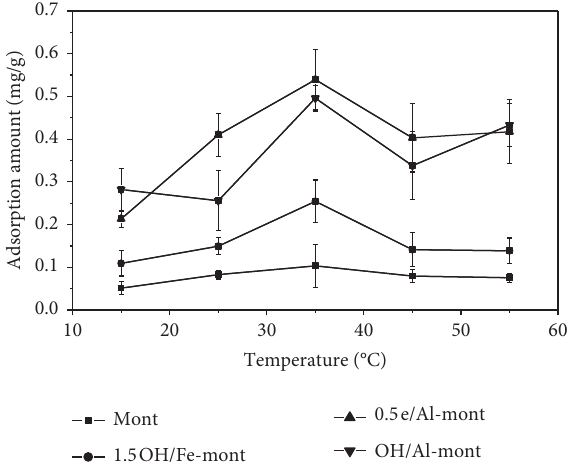
Figure 13: Effect of temperature on the ZEA adsorption capacity of